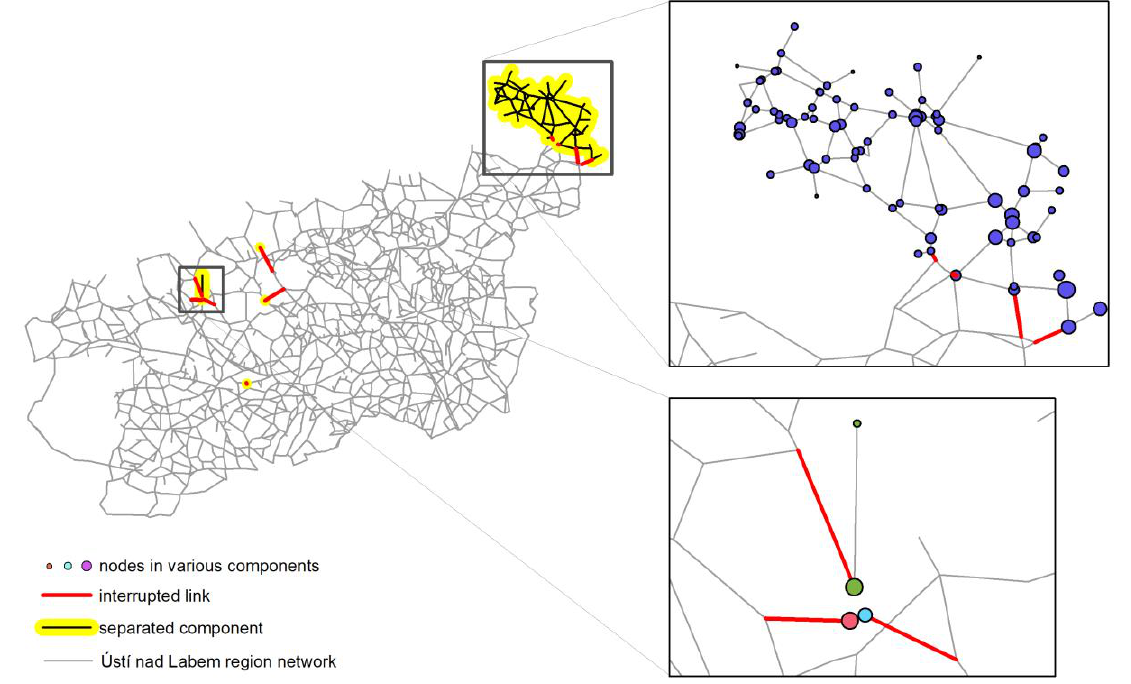
Figure 12. The worst scenario found by ANSA for ten concurrently interrupted road links in the Ústí nad Labem region network. 81,424 people (9.31%) cut off from the main